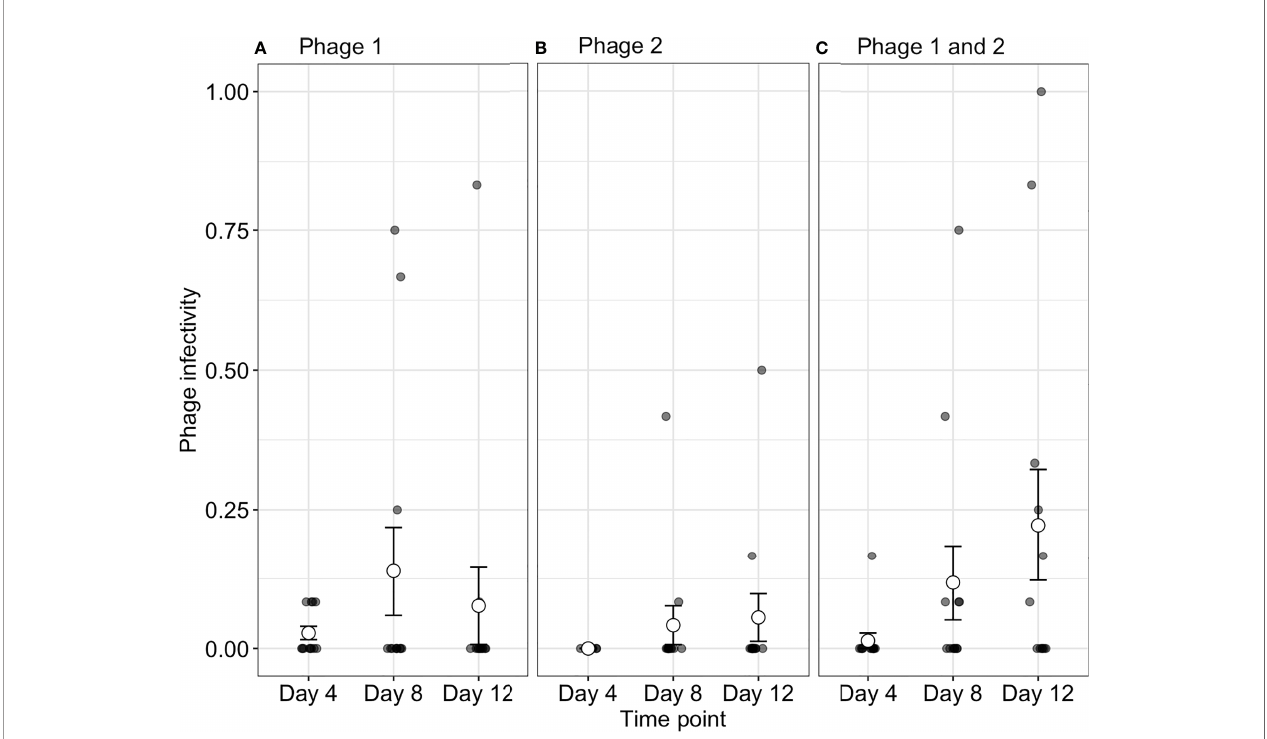
FIGURE 1 | Phage infectivity toward their contemporary bacterial populations. Infectivity is broadly consistent over time when phages are in monoculture (A, B) . In contrast, when phages are together in polyculture (C) , infectivity increases through time (i.e., the proportion of phage susceptible bacteria increases). Small points indicate the proportion of bacterial clones infected within a single treatment replicate. Large points represent the means of phage infectivity for phage isolated and tested against bacteria from different time-points. The bars show the ± SEs. Phage 1, P1; Phage 2,